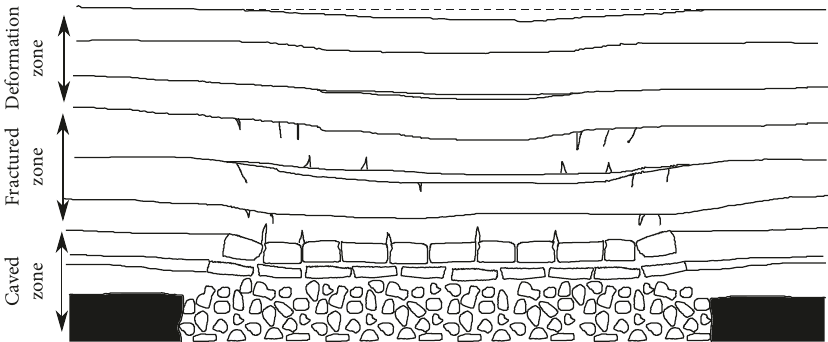
Figure 1: Different zones above an extracted longwall panel (adapted from